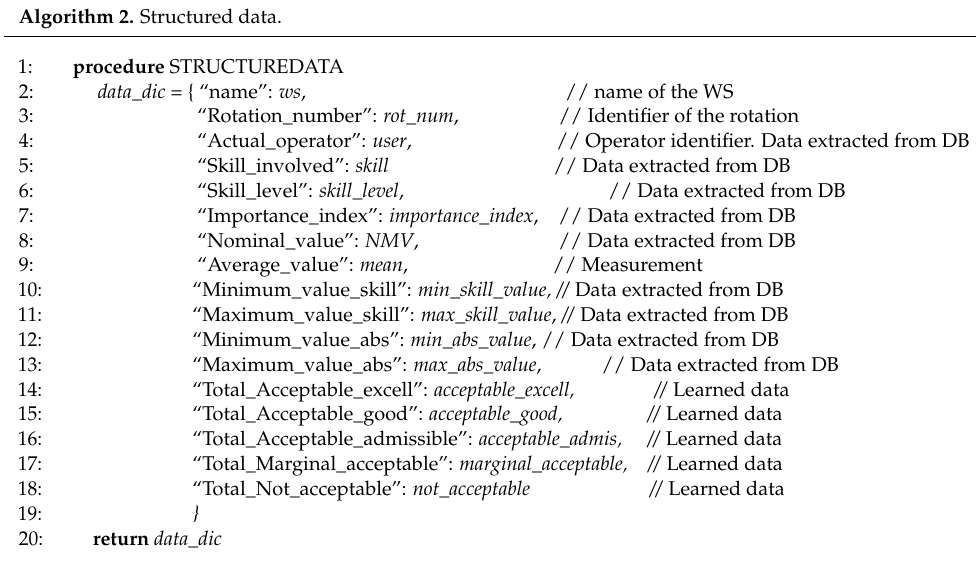
Algorithm 2. Structured